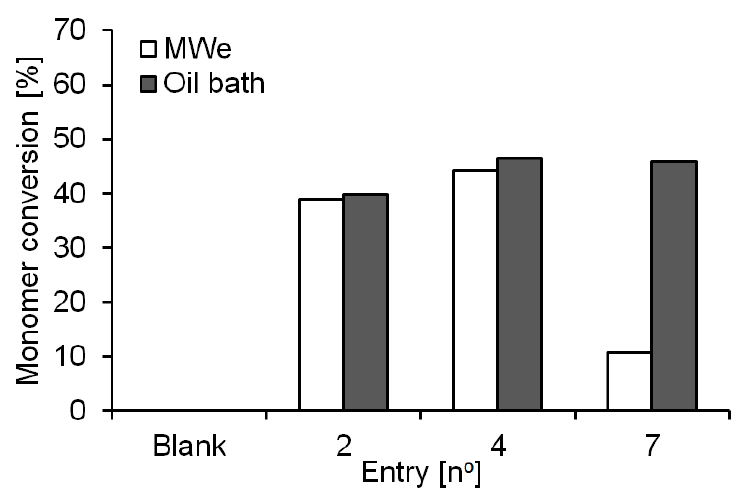
Figure 3. Monomers conversion overview from the bulk system reactions catalyzed by Novozym ® 435 at 50 °C and power of 200 W after 4 h. Conversions were calculated from 1 H-NMR analysis of the crude reaction products. 2: closed vessel; 4: open vessel; 7: Power Max function.